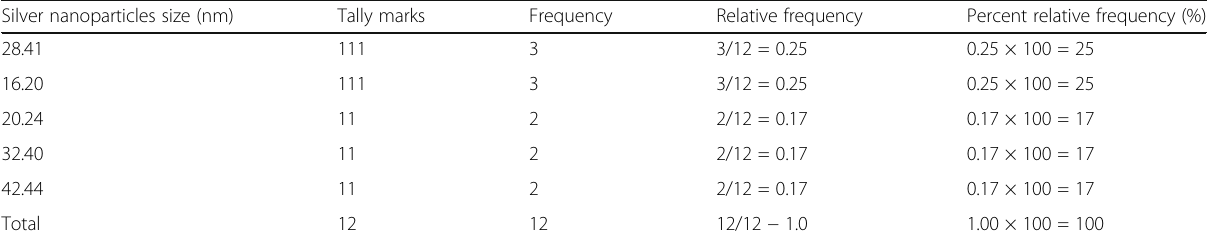
Table 2 Frequency distribution of silver nanoparticles size (nm) Silver nanoparticles size (nm)